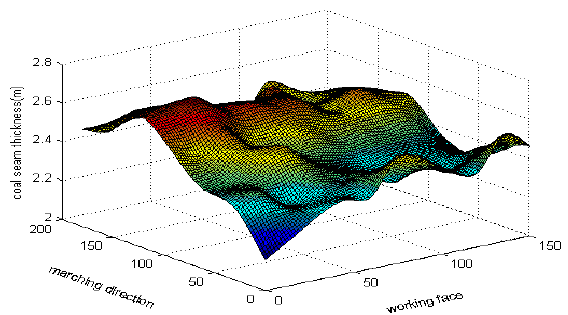
Figure 11. Interpolated surface from the real coal seam data